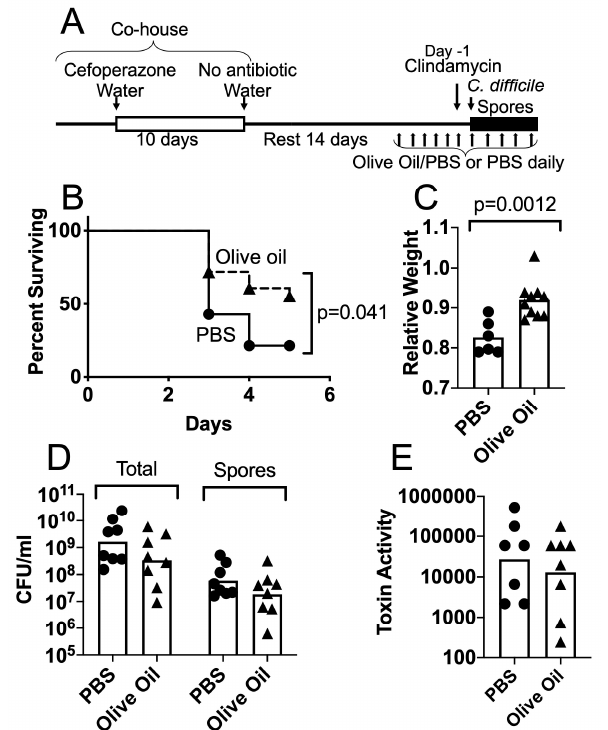
Figure 2. Olive oil feeding enhances the survival of the challenge with C. di ffi cile spores in the antibiotic-treated mice. Outline of the mouse regimen is shown in ( A ). The C57BL / 6 mice were co-housed in a large cage and received antibiotics as described in the Materials and Methods (cefoperazone 10 days). Mice were then transferred to the standard size cages with water without additives, rested 14 days, and then received a daily oral administration of olive oil with PBS or PBS only. Mice received clindamycin ip and the following day received C. di ffi cile spores (3–5 × 10 5 spores of strain UK1, a NAP1 / 027 / BI human epidemic strain) by oral inoculation. ( B ) Survival of the mice was monitored for 5 days post-inoculation with spores (PBS, n = 14; Olive oil, n = 18; log rank test p = 0.041). ( C ) Panel shows the relative weights of the surviving mice on day 3 post-inoculation ( t test p = 0.0012). ( D ) C. di ffi cile bacteria were enumerated by plating the homogenized cecum contents collected from the mice sacrificed on day 2 post-inoculation. Homogenates were plated on a TCCFA medium (total) or heated at 60 ◦ C for 10 min and plated (spores). ( E ) C. di ffi cile toxin activity in the cecum contents from the mice sacrificed on day 2 post-inoculation was measured using a cell-rounding assay. The inverse of the greatest dilution that yielded 100% cell rounding is plotted. Circles, antibiotic treated, uncolonized; triangles, antibiotic treated, C. albicans